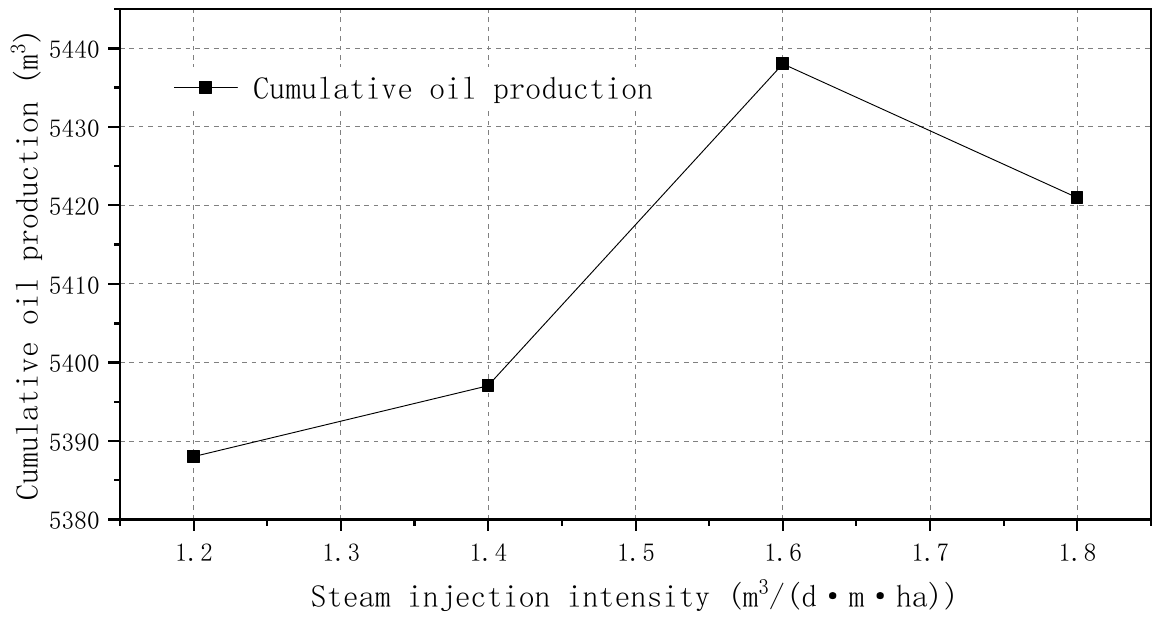
Figure 12. The change of temperature of the well head of production well.